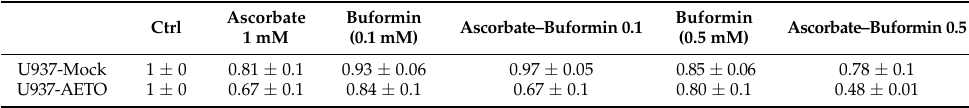
Table 9. Cellular Viability response to different metabolic treatments of U937-AETO/U937-Mock cell